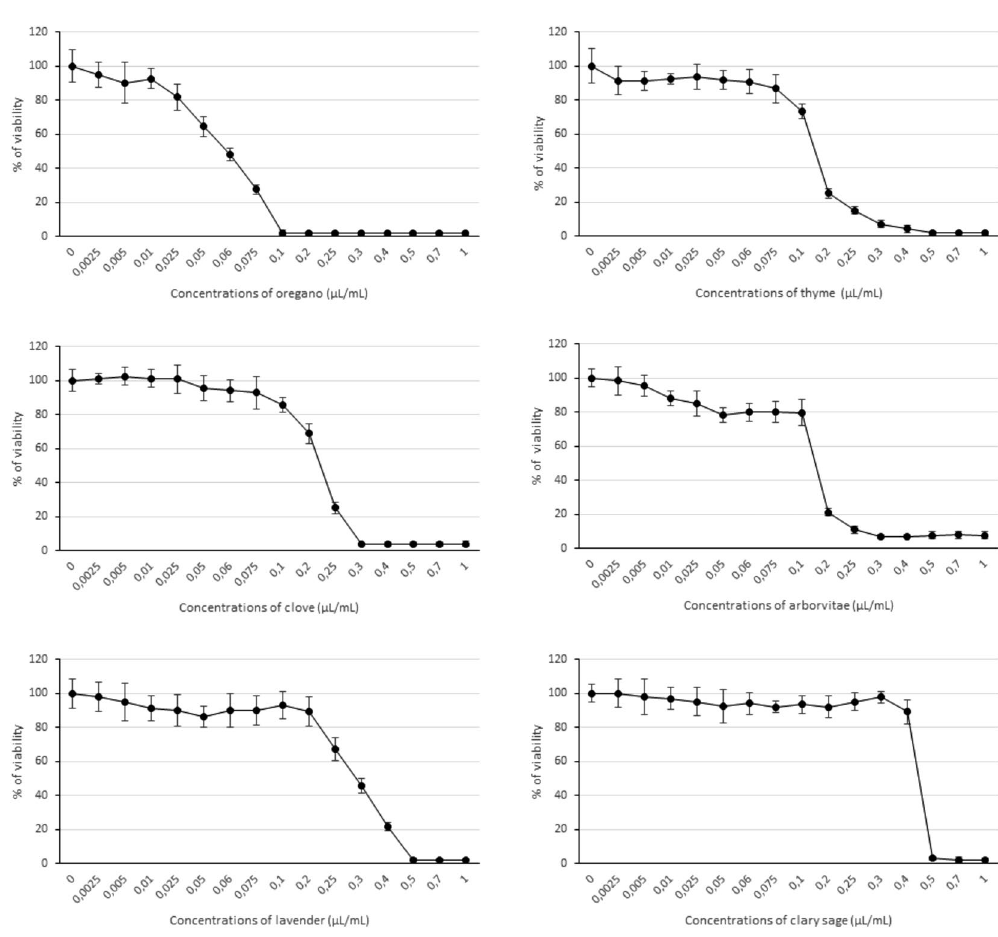
Figure 5. Cytotoxicity or viability of human HEL 12469 cells. The effects of a 24 h treatment of different concentrations of EOs (0.0025–1.0 µ L/mL) are shown. Data are represented means ± 1 SD of 3 independent